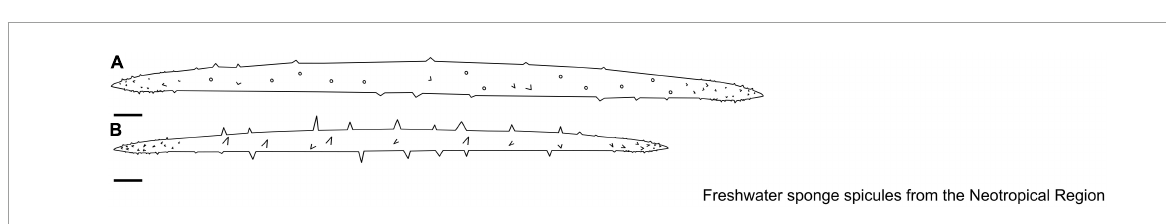
FIGURE14 (A,B) Balliviaspongia Boury-Esnault & Volkmer-Ribeiro, 1991. Megascleres. (A,B) Acanthoxeas. Scale: 10 µ m.